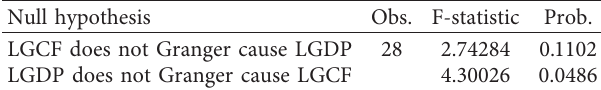
Table 6: Granger causality test result.